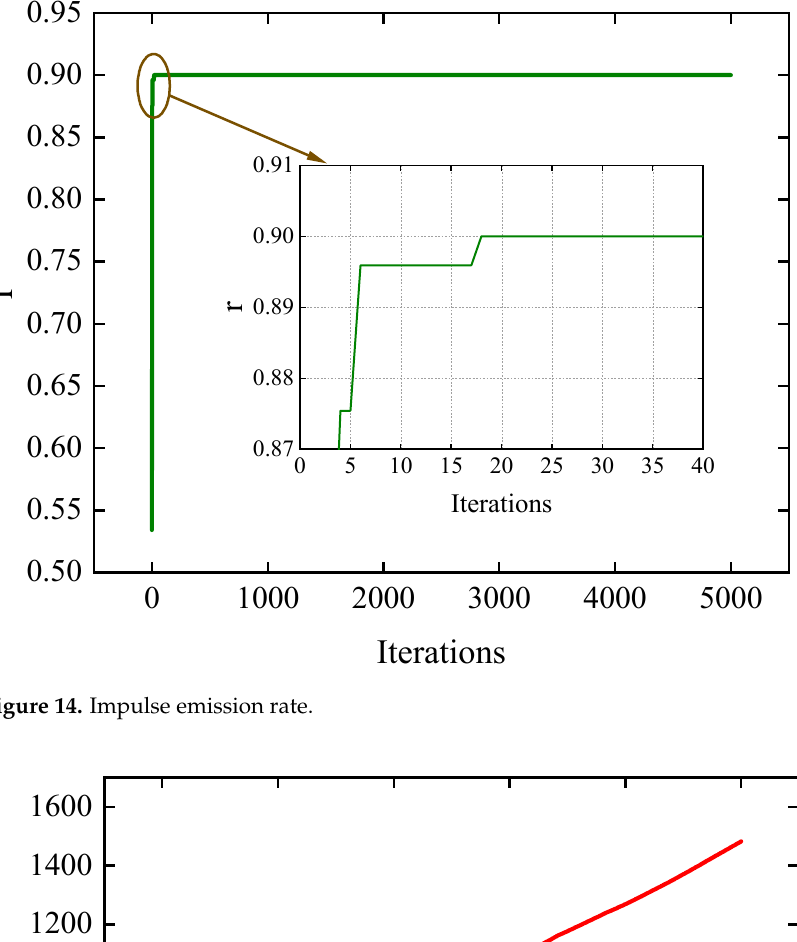
Figure 13. Impulse loudness.